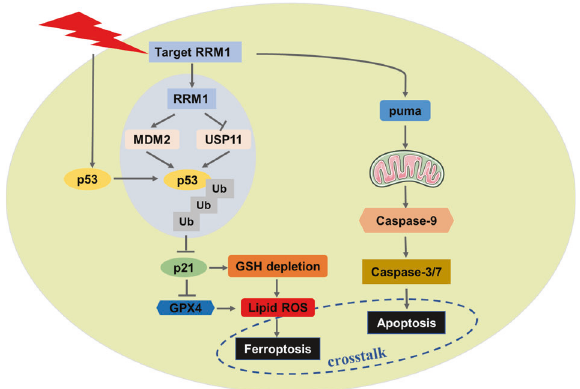
Fig. 7 Schematic illustration of the proposed model. The mechanism of RRM1-mediated radiosensitization of cancer